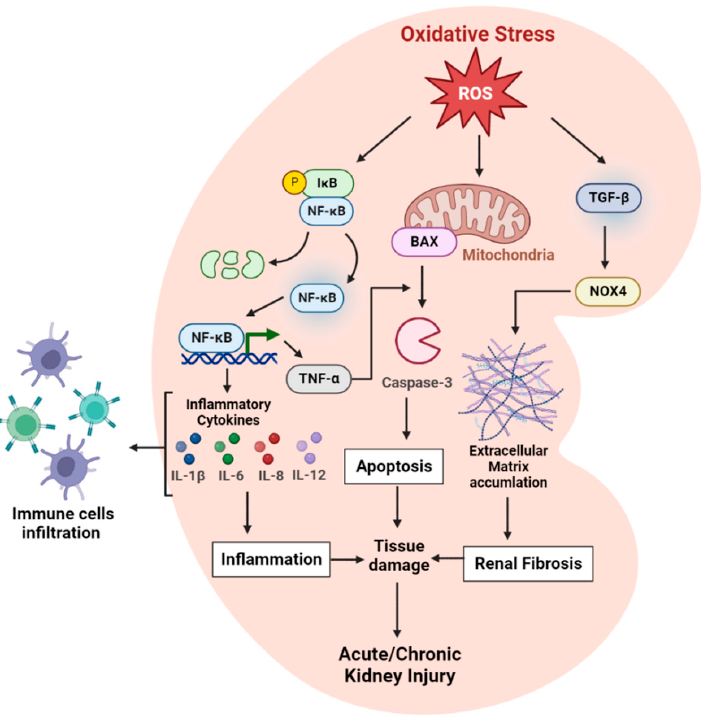
Figure 2. Oxidative stress and inflammation in the kidney. Oxidative stress in the kidney is induced by reactive oxygen species (ROS) from mitochondrial, cytoplasmic, and extracellular sources. Under ROS stress, the NF- κ B pathway is activated, inducing a proinflammatory response with cytokine secretion (IL-1 β , IL-6, IL-8, and IL-12). The cytokines lead to leukocyte infiltration, causing an additional burst of oxidative stress. ROS also increases Bax/Bcl2 ratio in the mitochondrial membrane that activates caspase-3, resulting in apoptosis. In addition, the increased expression of TNF- α by the NF- κ B pathway induces apoptosis by forming a death-inducing signaling complex that leads to the cleavage of caspase-3. An increased ROS level activates the TGF- β pathway leading to the extracellular matrix accumulation, causing kidney fibrosis, progressing to renal tissue damage, and acute/chronic kidney injury. 3. Nephroprotective Effects of Flavonoids The protective effects of flavonoids against chemically induced renal toxicity have been widely studied over recent years. Arterial hypertension, oxidative stress, inflammatory diseases, and changes in vascular health could challenge renal health. Flavonoids mitigate these effects and have shown promising results in treating acute and chronic nephropathies, renal fibrosis, and anti-tumor activity [58]. Flavonoids may also act directly on the renal parenchyma and interfere with signaling pathways, affecting the development of renal injury and exerting nephroprotective effects in glomerulonephritis, diabetic nephropathy, and chemically induced kidney insufficiency [58,59]. Flavonoids exert protective effects by decreasing the excessive ROS level or activating renal enzymatic and non-enzymatic antioxidants via different pathways, including modulating the Nrf2- antioxidant pathway [60,61]. Herein, we have assessed and summarized (Table 1) the most reported flavonoids and their nephroprotective mechanisms against oxidative stress, inflammation, DNA damage, and cell death (Figure 3).